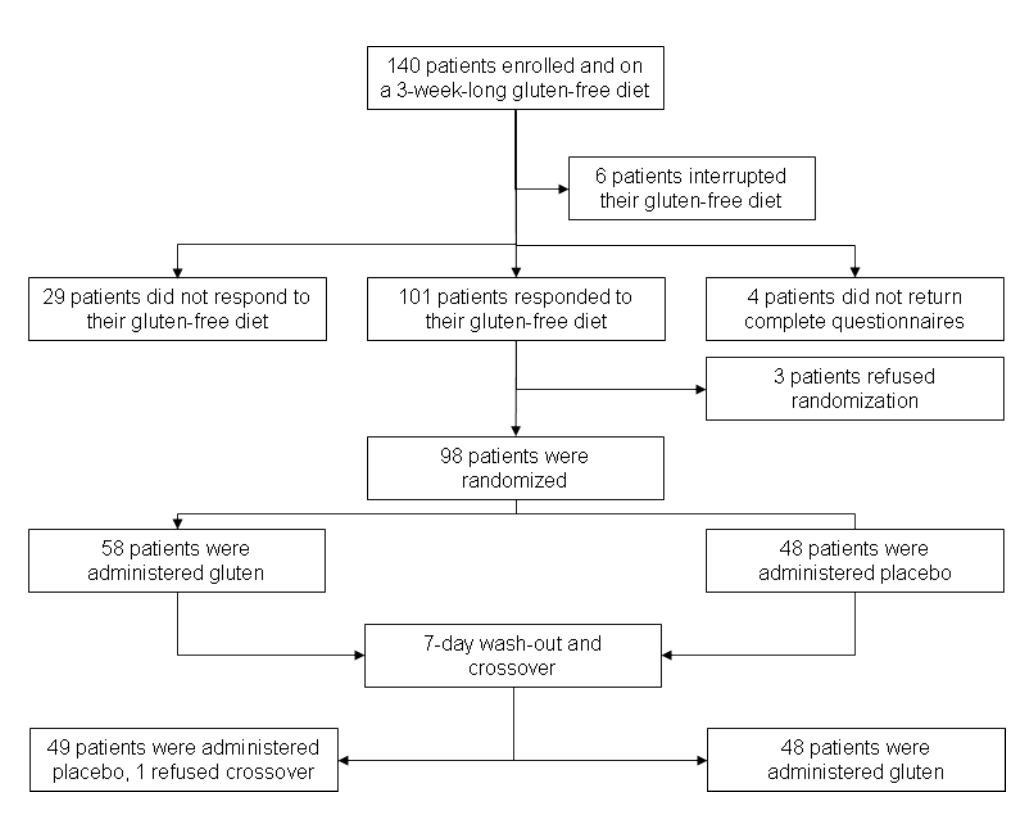
Figure 1. Trial profile. Table 1. Clinical and demographic characteristics of enrolled patients during Phase 1 of the GLUTOX trial (see Methods section). The characteristics of all the patients, distinguishing those responsive/non-responsive to the gluten-free diet (GFD), are reported.